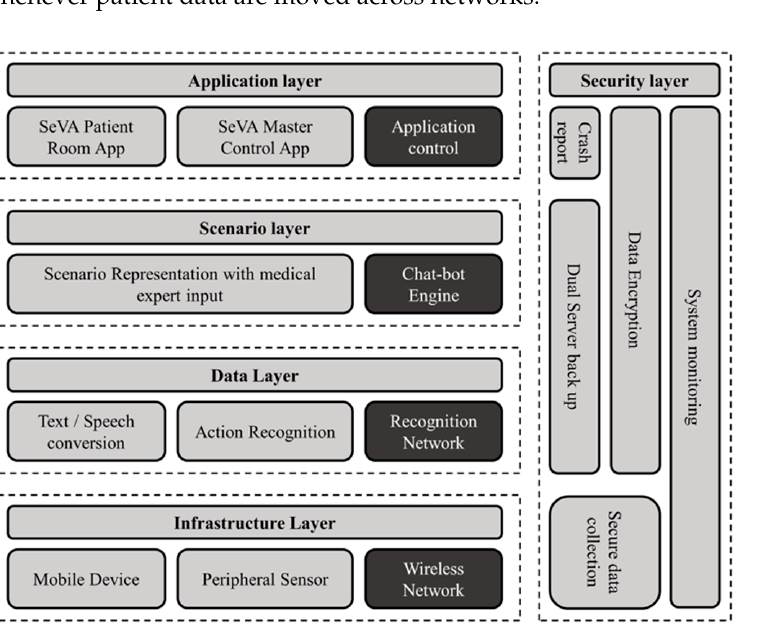
Figure A1. Communication of information supported by the SeVa system framework.